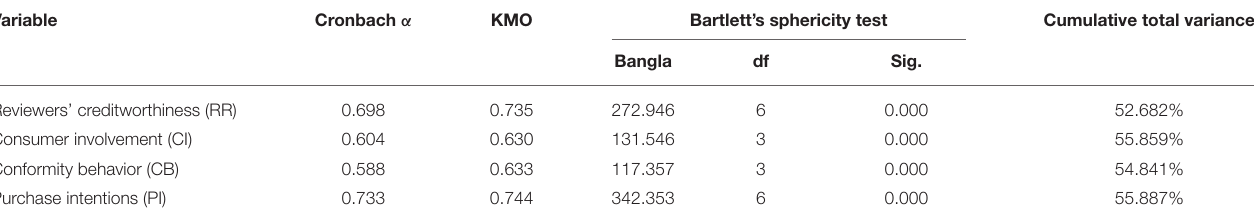
TABLE 2 | Reliability and validity of the scale.